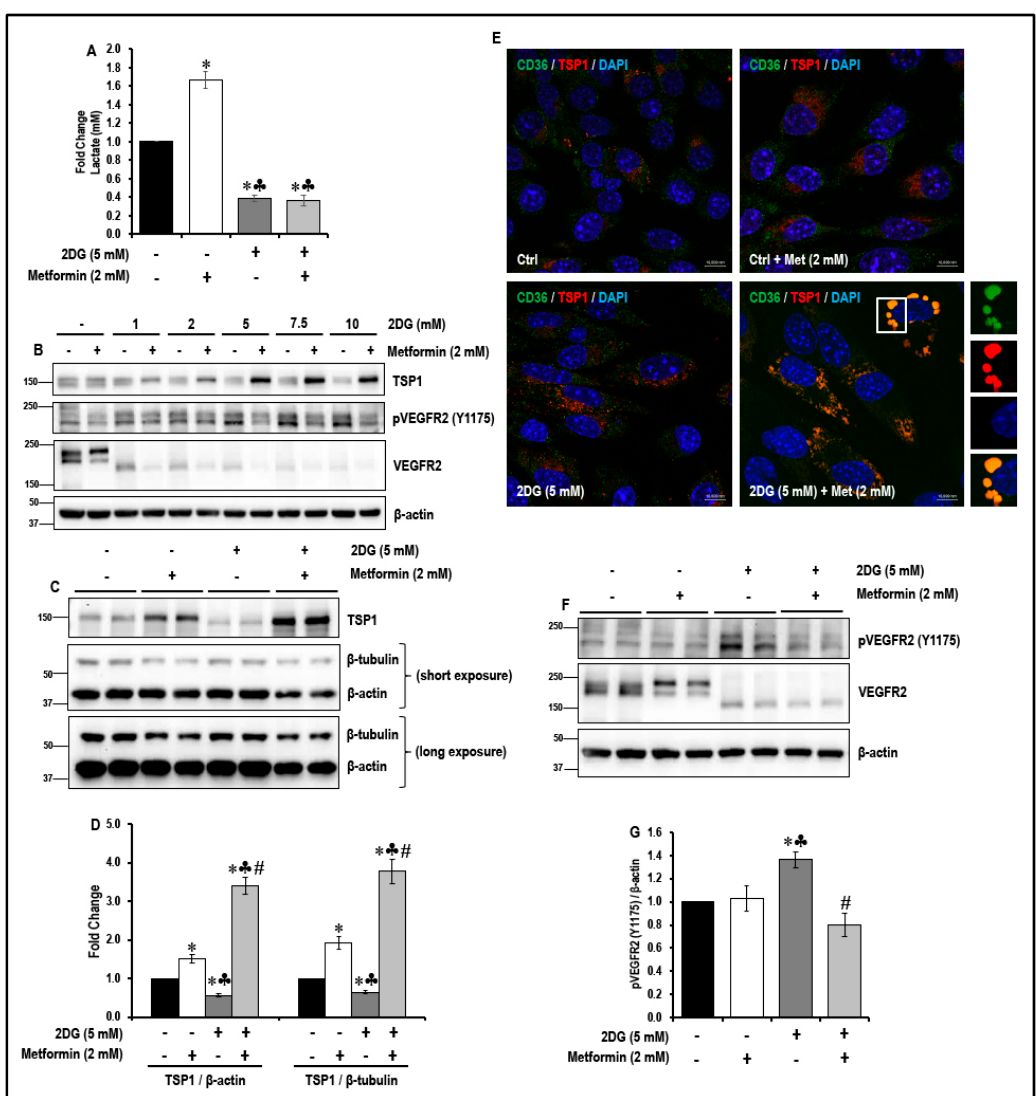
Figure 2. E ff ect of metformin treatment on glycolysis, levels of TSP1, TSP1-platelet glycoprotein IV / scavenger receptor class B member 3 (CD36) co-localization and levels of phosphorylated vascular endothelial growth factor receptor-2 (pVEGFR2; Y1175) in normal glucose and 2-deoxyglucose (2DG)-exposed MMECs (48 h): Bar graphs ( A ) represent fold change in the levels of lactate (mM) in the cells treated with 2DG (5 mM) with or without metformin (2 mM), after 48 h in culture. Representative Western blots ( B ) show the levels of TSP1, pVEGFR2 (Y1175) and VEGFR2 in MMECs treated with varying concentrations of 2DG with or without metformin (2 mM), after 48 h in culture. Representative Western blots ( C ) show the levels of TSP1 while ( F ) show the levels of pVEGFR2 (Y1175) and VEGFR2 in cells exposed to 2DG (5 mM) in the presence or absence of metformin (2 mM), after 48 h in culture. Non-treated cells and cells treated with metformin (2 mM) alone were used as suitable controls. Bar graphs ( D ) represent levels of TSP1 / β -actin and TSP1 / β -tubulin (normalized against β -actin and β -tubulin loading controls) while bar graphs ( G ) represent ratio of pVEGFR2 (Y1175) / β -actin in the cells treated with 2DG (5 mM) with or without metformin (2 mM), after 48 h in culture. * p < 0.05 indicates significance when compared to non-treated controls, ♣ p < 0.05 indicates significance when compared to control + 2 mM metformin-treated cells and # p < 0.05 indicates significance when compared to 2DG (5 mM)-treated cells. Representative immunofluorescence confocal images ( E ; from three experiments) show TSP1 (red) and CD36 (green) staining in MMECs exposed to 2DG (5 mM) in the presence or absence of metformin (2 mM). Nuclear stain, 4 (cid:48) ,6-diamidino-2-phenylindole (DAPI; blue), has been used to stain the nuclei. Scale bar = 10 µ